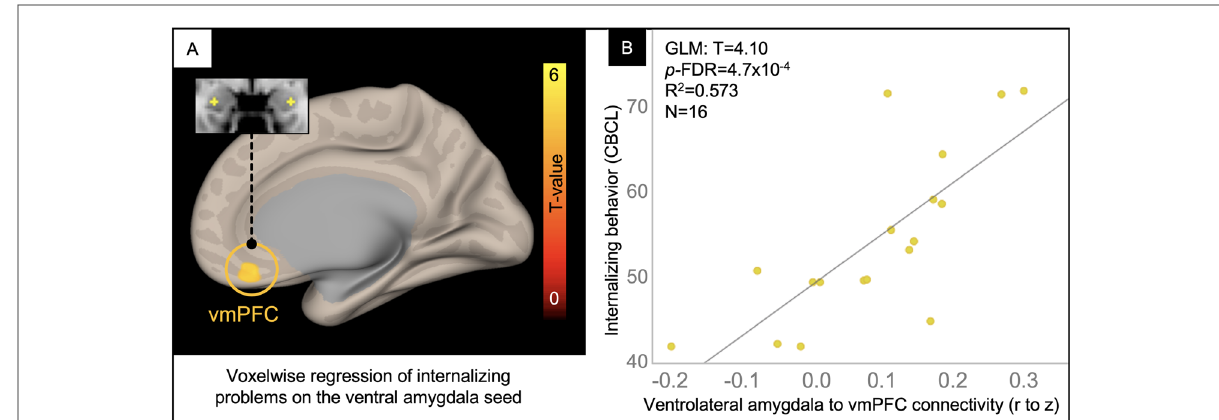
FIGURE 5 Voxelwise correlation between CBCL Internalizing Problem ratings and ventrolateral amygdala connectivity. Resultant clusters of voxels in the ventromedial prefrontal cortex (vmPFC) for the regression of Internalizing problem ratings from the CBCL on ventrolateral amygdala rFC ( A , p -uncorrected<0.01 with cluster-size p -FDR corrected<0.05). Scatter plot ( B ) showing the correlation between rFC of the ventrolateral amygdala to peak voxel in the vmPFC cluster (x-axis) and Internalizing Problem ratings from the CBCL (y-axis) with overlaid statistics for the GLM (given these were derived from the voxelwise